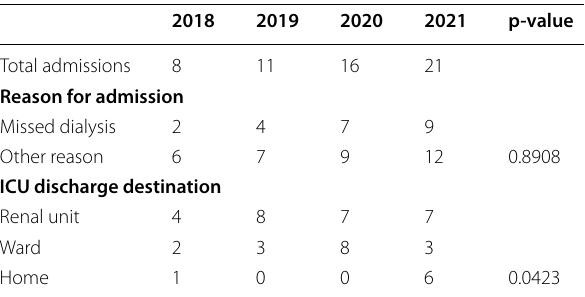
(Table 1). Table 1: ICU admissions for ESRF patients requiring only CVVH